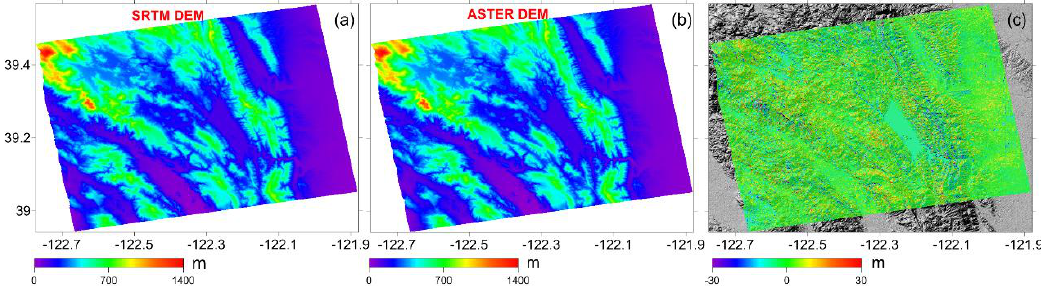
Figure 3. ( a ) Shuttle Radar Topography Mission digital elevation model (SRTM DEM); ( b ) Advanced Spaceborne Thermal Emission and Reflection Radiometer (ASTER) DEM; ( c ) Difference map between the SRTM DEM and the ASTER DEM.